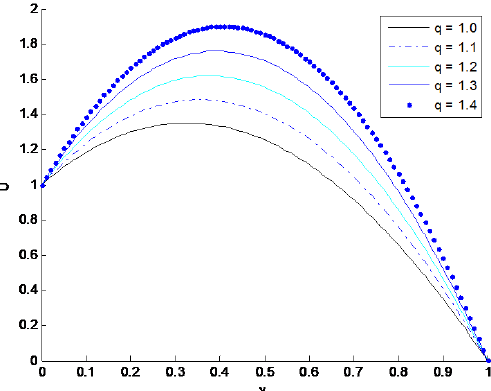
Figure 14: Velocity profile for different values of mass flux q ( Br =